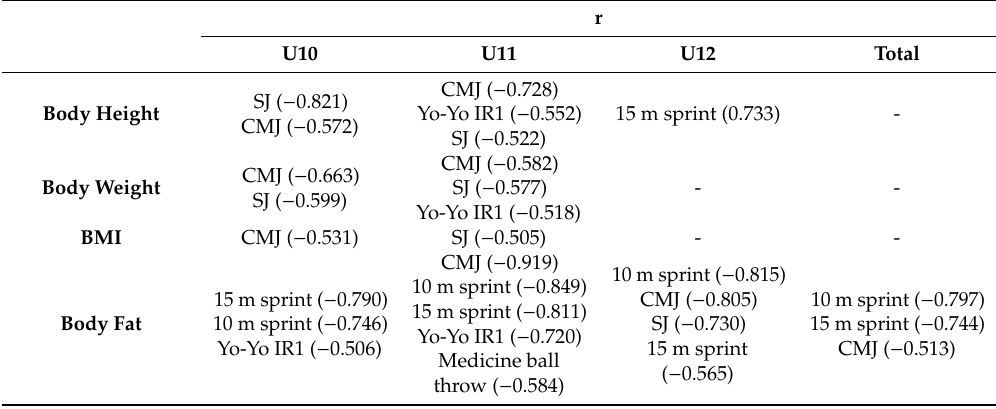
Table 5. Correlation coe ffi cients between anthropometric and physical fitness parameters in relation to age groups. Only relevant correlation coe ffi cients (r ≥ 0.5) are